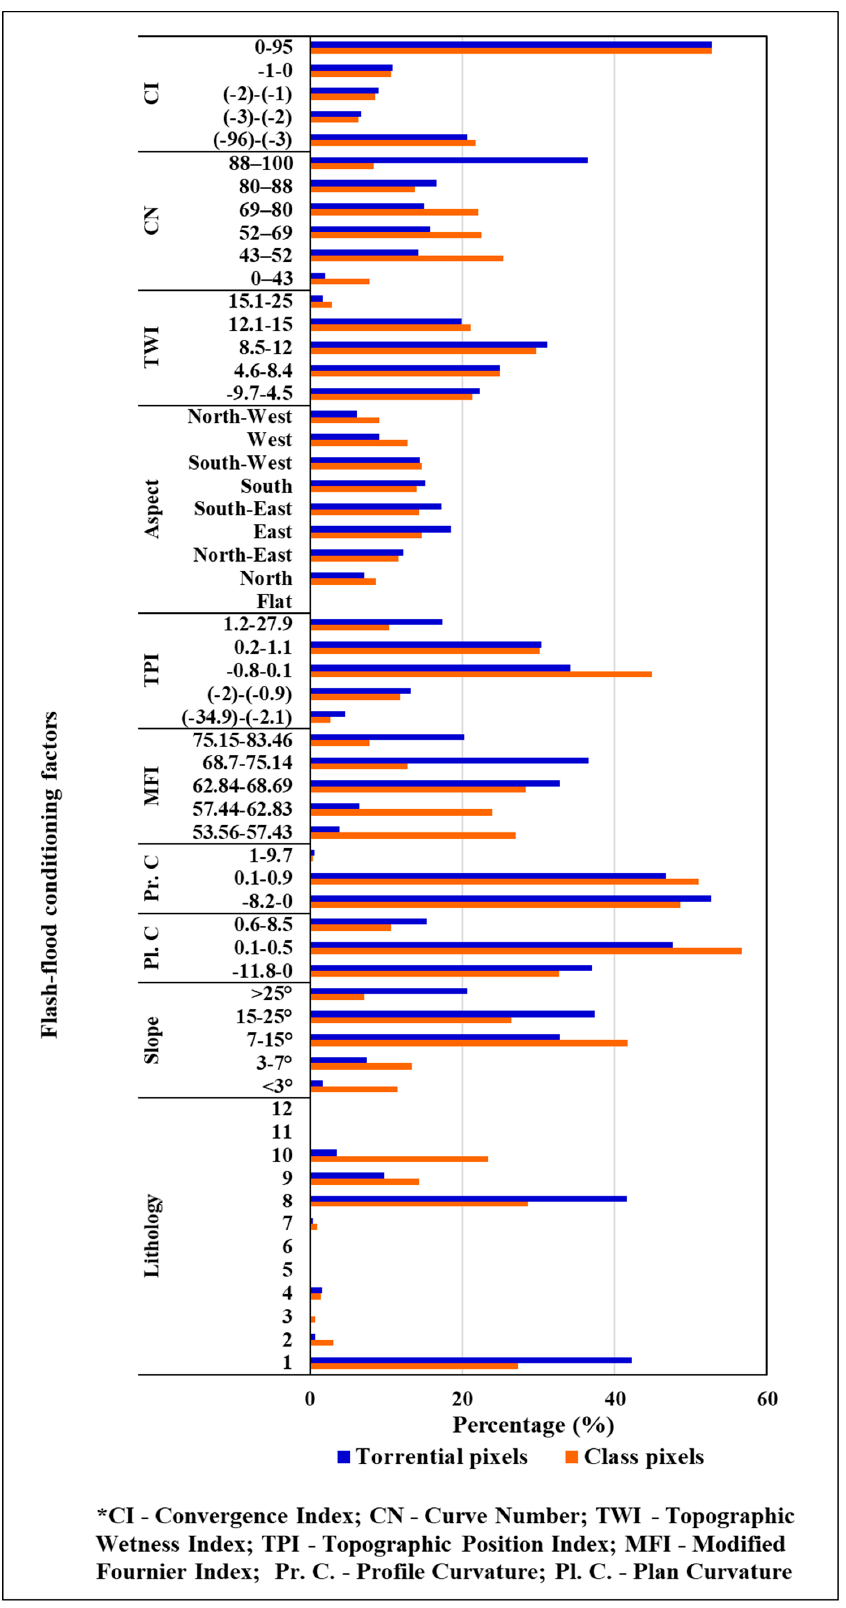
Figure 4. Relative frequency distribution of torrential phenomena pixels in classes of flash-flood predictors.